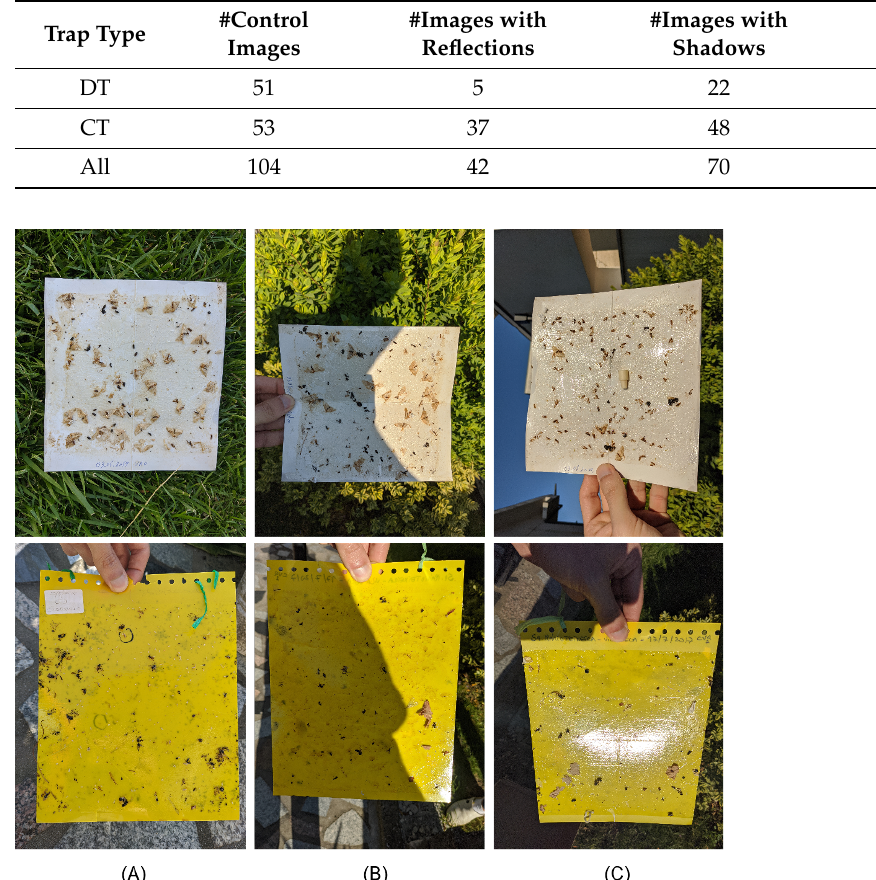
Figure 3. Illustrative images labeled as: ( A ) good illumination; ( B ) with shadows; ( C ) with